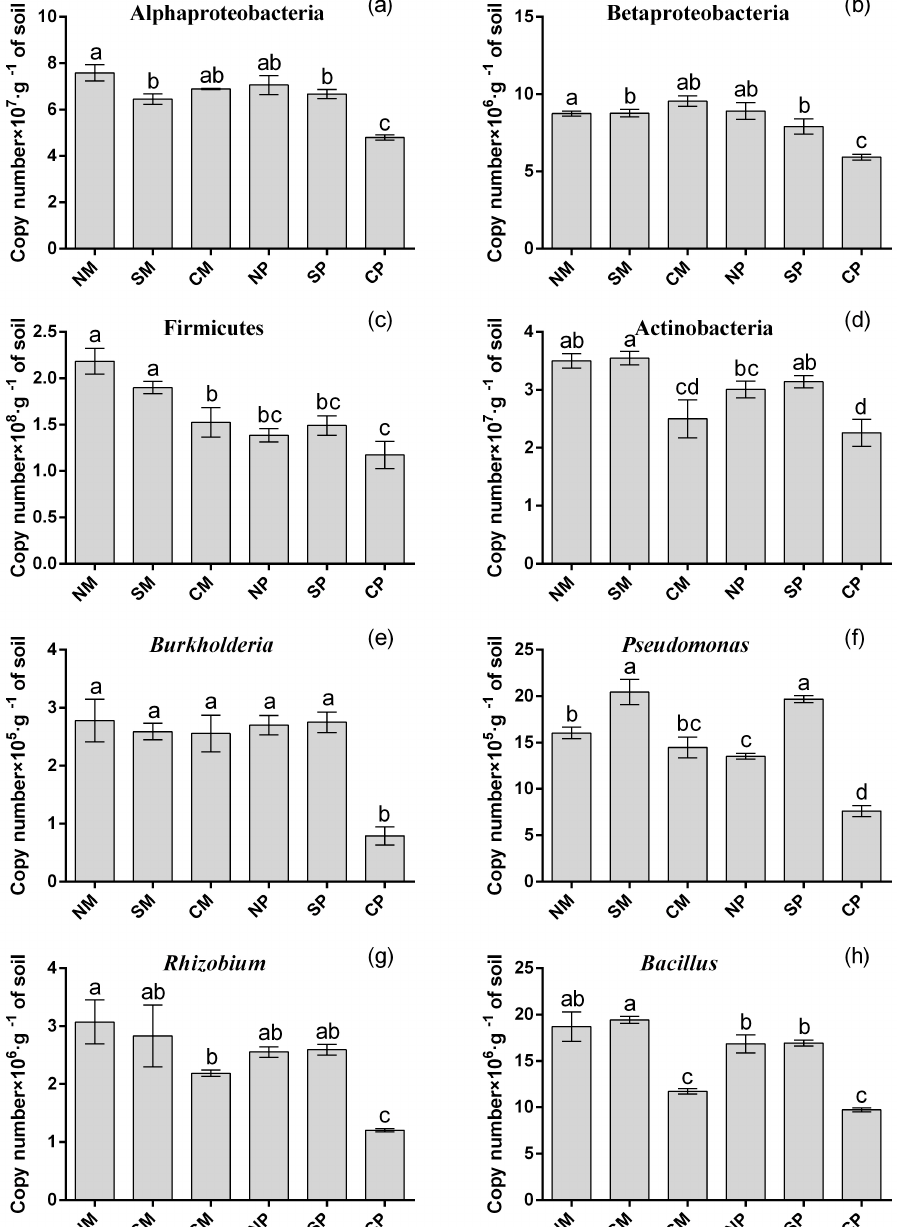
Figure 5. Quantification of genes involved in major microbial communities under different intercropping patterns. ( a ): Alphaproteobacteria; ( b ): Betaproteobacteria; ( c ): Firmicutes; ( d ): Actinobacteria; ( e ): Burkholderia ; ( f ): Pseudomonas ; ( g ): Rhizobium ; ( h ): Bacillus . NM: non-separated maize; SM: semi-separated maize; CM: completely separated maize; NP: non-separated peanut; SP: semi-separated peanut; CP: completely separated peanut. Bars with different letters indicate significant differences (LSD’s test, p < 0.05, n = 4).